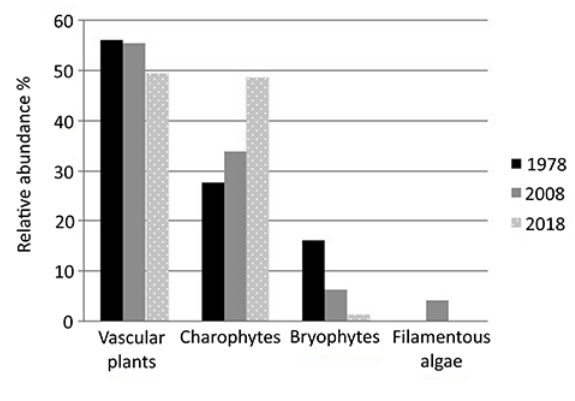
Figure 4 e relative abundance of macrophyte groups (%) in Lake Kuźnickie in the summer seasons of 1978, 2008, and 2018. To calculate the abundance of each group of macrophytes the following data were processed: 1978 – Gołdyn (1983); 2008 – monitoring data of Voivodship Inspectorate of Environmental Protection in Poznań (VIEP in Poznań, 2008); 2018 – this original study.